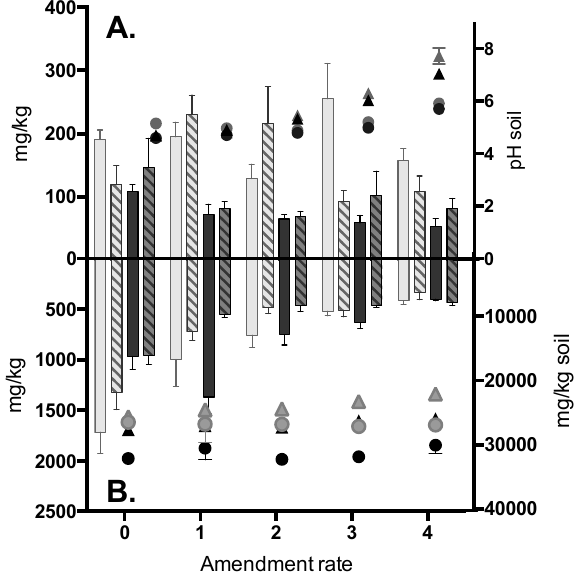
Figure 2. The aluminum concentration of shoots ( A ) and roots ( B ) grown in Freeman (light grey) or Bernhill (dark grey) soils amended with KB- (solid) or wood- (cross- hatched) sourced biochars. The pH of the soils (right axis, (A)) and the soil aluminum concentration (right axis, (B)) is also plotted for Freeman (light grey) or Bernhill (dark grey) soils amended with KB- (circle) or wood- (triangle) sourced biochars (Trippe 2015). Amendment rates are represented as 0–4, which correspond to rates of 0%, 3%, 6%, 16%, and 25% by volume for both biochars, 0%, 0.7%, 1.7%, 3.7%, and 8.6% by mass for wood biochar, and 0%, 0.4%, 1.2%, 2.5%, and 5.8% by mass for KB-sourced